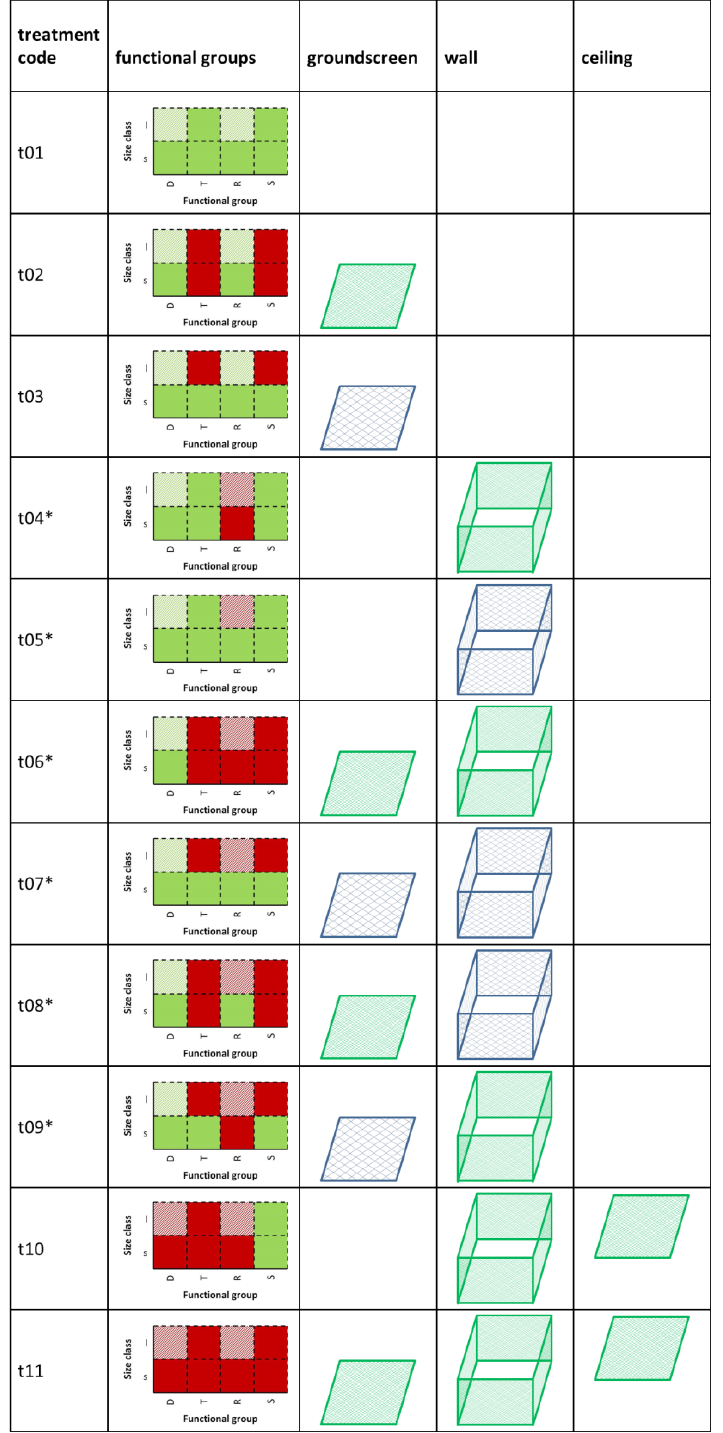
Table 4. Treatments used in the dung and seed removal experiments and the functional groups (with D= dwellers, T= tunnelers, R= rollers, and S= soil macro-invertebrates) and size classes (with l= large and s= small body size) able to move dung in each treatment. Green boxes indicate the inclusion of a functional group; red boxes mark excluded groups. Large dweller or roller species were not found (dashed boxes). Materials used for ground screens, walls and ceilings were either fine mesh (green, 1 mm²), or coarse mesh (blue, 1 cm²). Exclosure types marked with an asterisk (*) were not built at study sites where no rolling species occur (Bavarian Forest NP, Castillo de Viñuelas, Le Chesnoy, Lygra, Moor House NP, Steinbühl, Tähtvere parish, Vácrátót and Swindon in all experimental runs, and in Bugac, Bayreuth and Kalmthout during the experiments in 2015). In the control treatment (t11), dung degradation was measured in the absence of invertebrates unable to move through 1 mm²